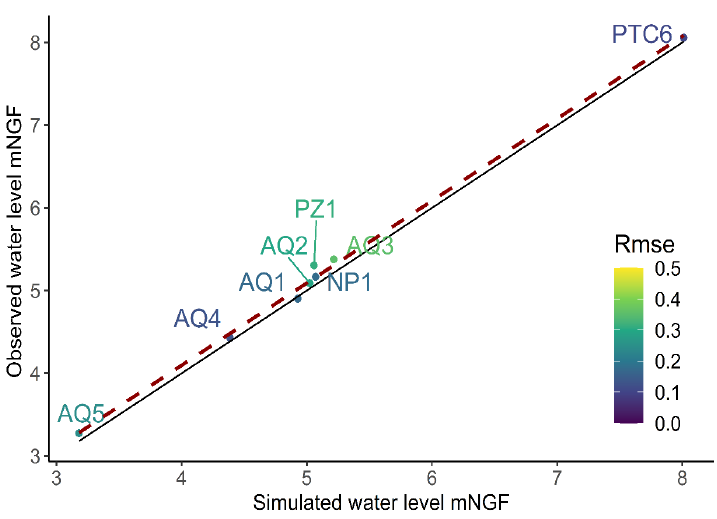
Figure 7. Plot of observed and simulated mean water levels and associated calculated RMSE for the different observation wells. The black line is an x = y function, the red dashed line is the calculated fit line.